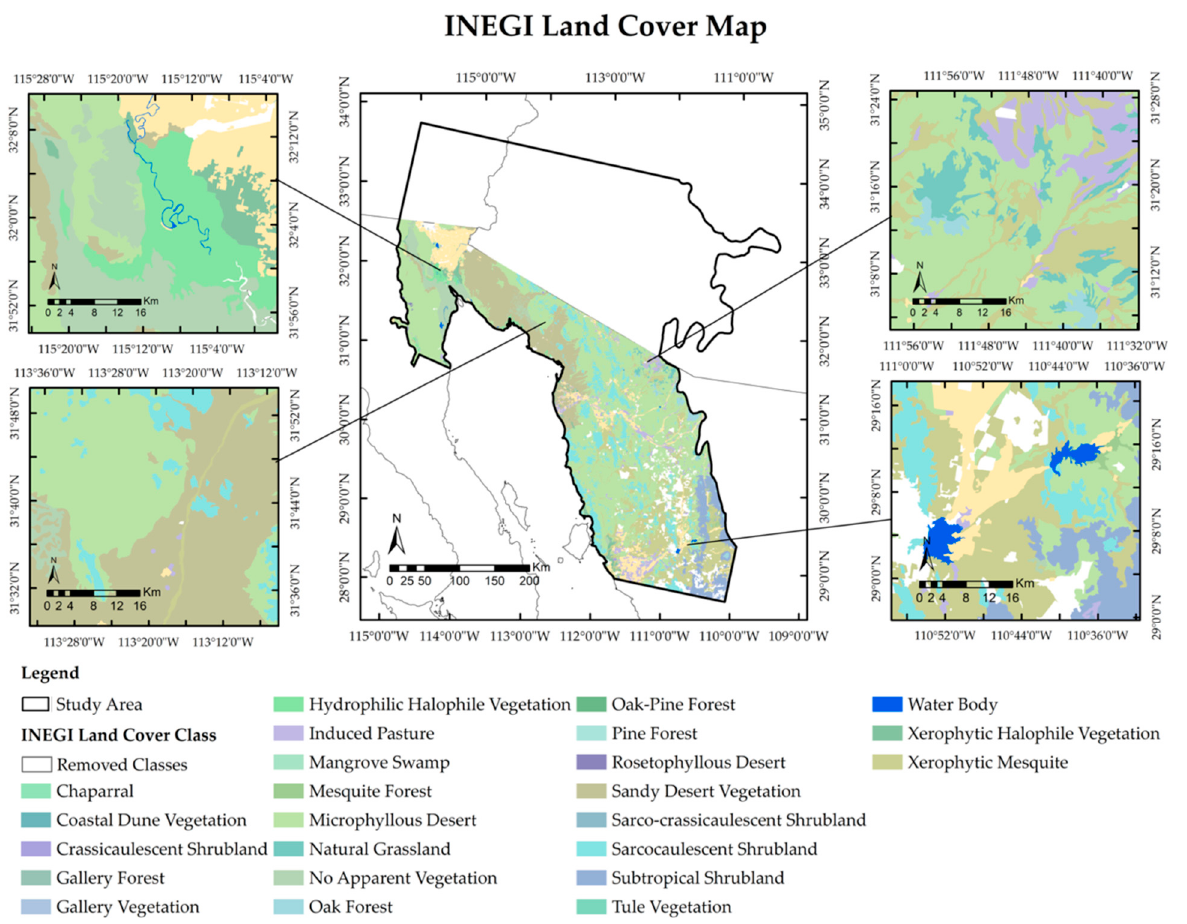
Figure 3. INEGI land use and vegetation data within the study area. A total of 24 classes were selected. Removed classes included agriculture and urban areas, which were added at a later time to the final